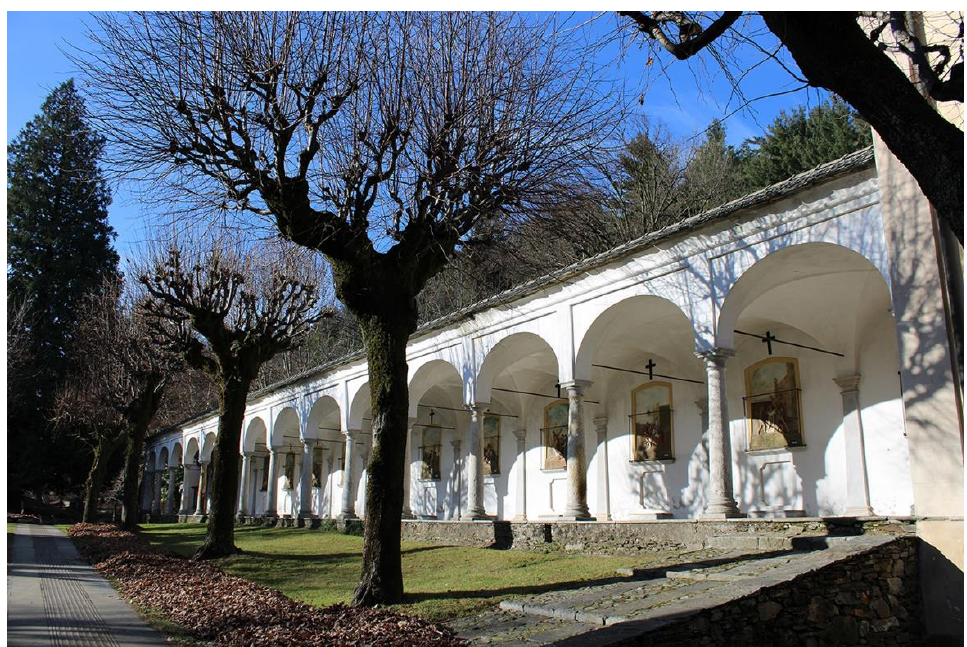
Figure 1. The Via Crucis portico inside the Sacro Monte of Ghiffa (Piedmont, Italy).